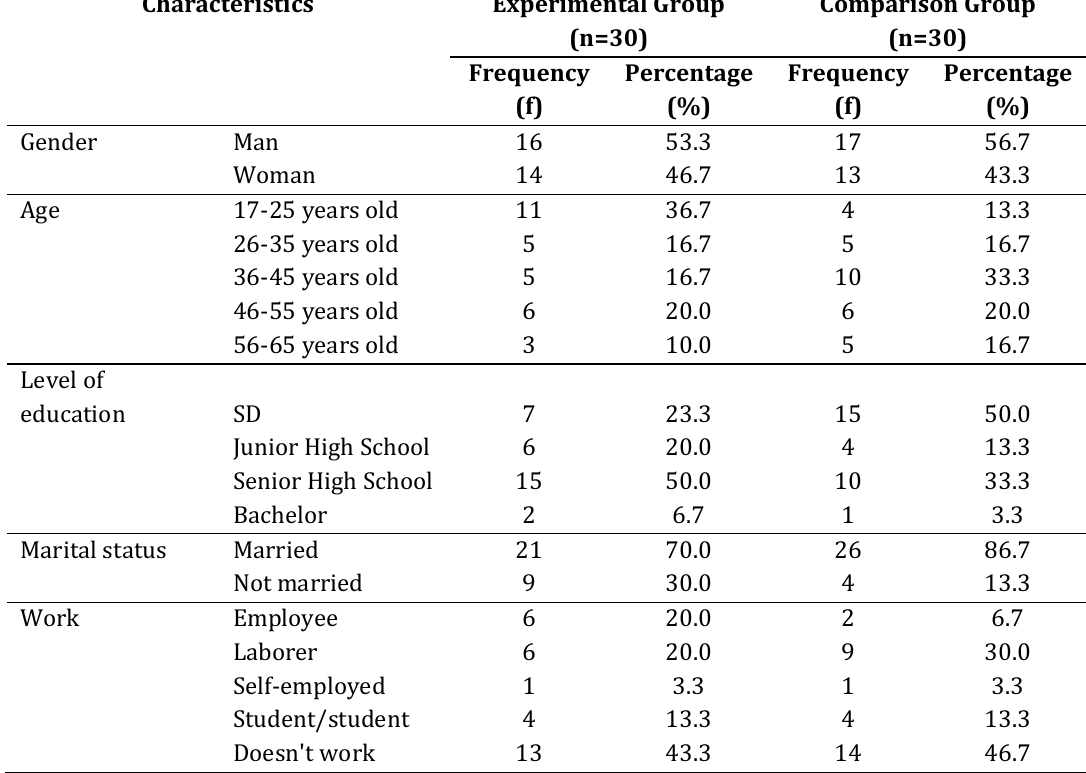
Characteristics of